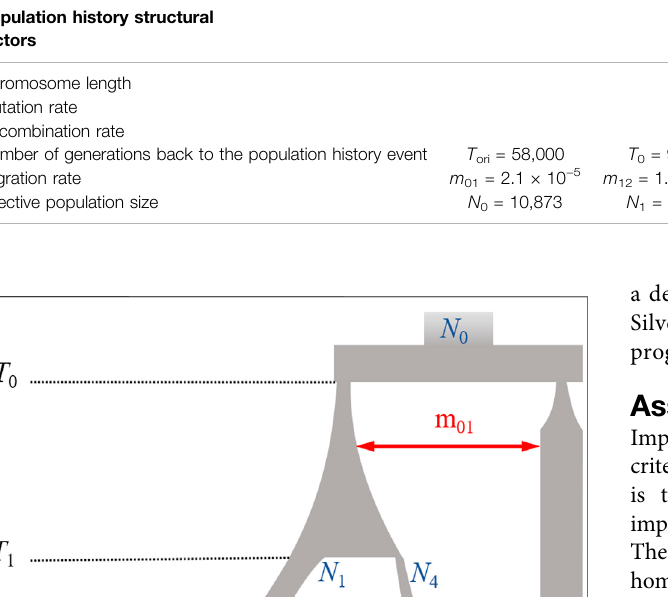
TABLE 1 | Parameters used of the simulation with msprime .